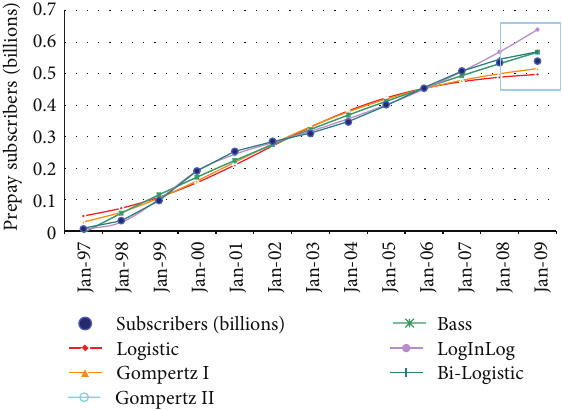
Figure 25: The forecasting performance of the modified-hGP (forecast window—2 years ahead) for the number of OECD mobile contract subscribers.